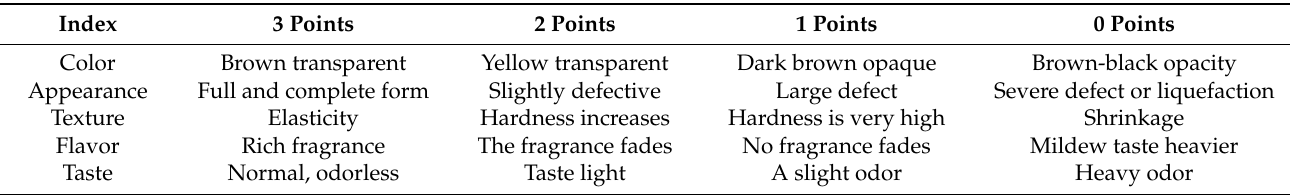
Table 1. Sensory